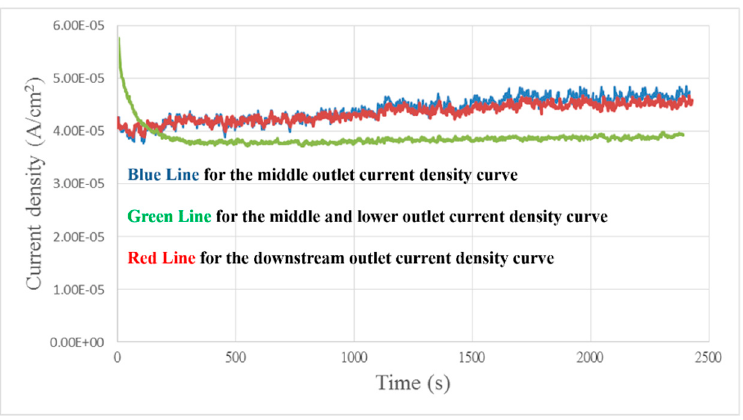
Figure 10. Current density curve diagram of different runners.